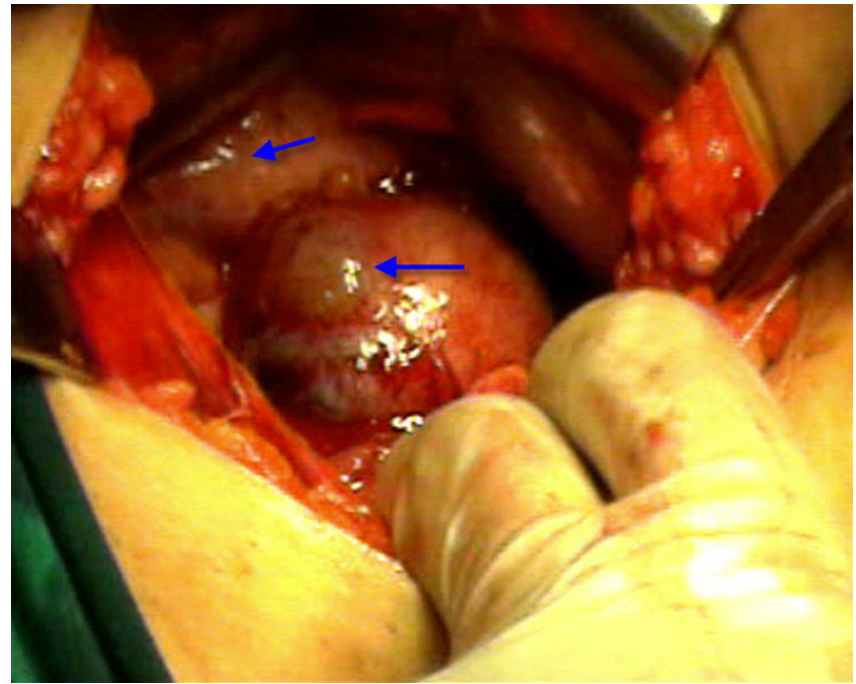
FIGURE 4. Yellowish-brown, tense, cystic